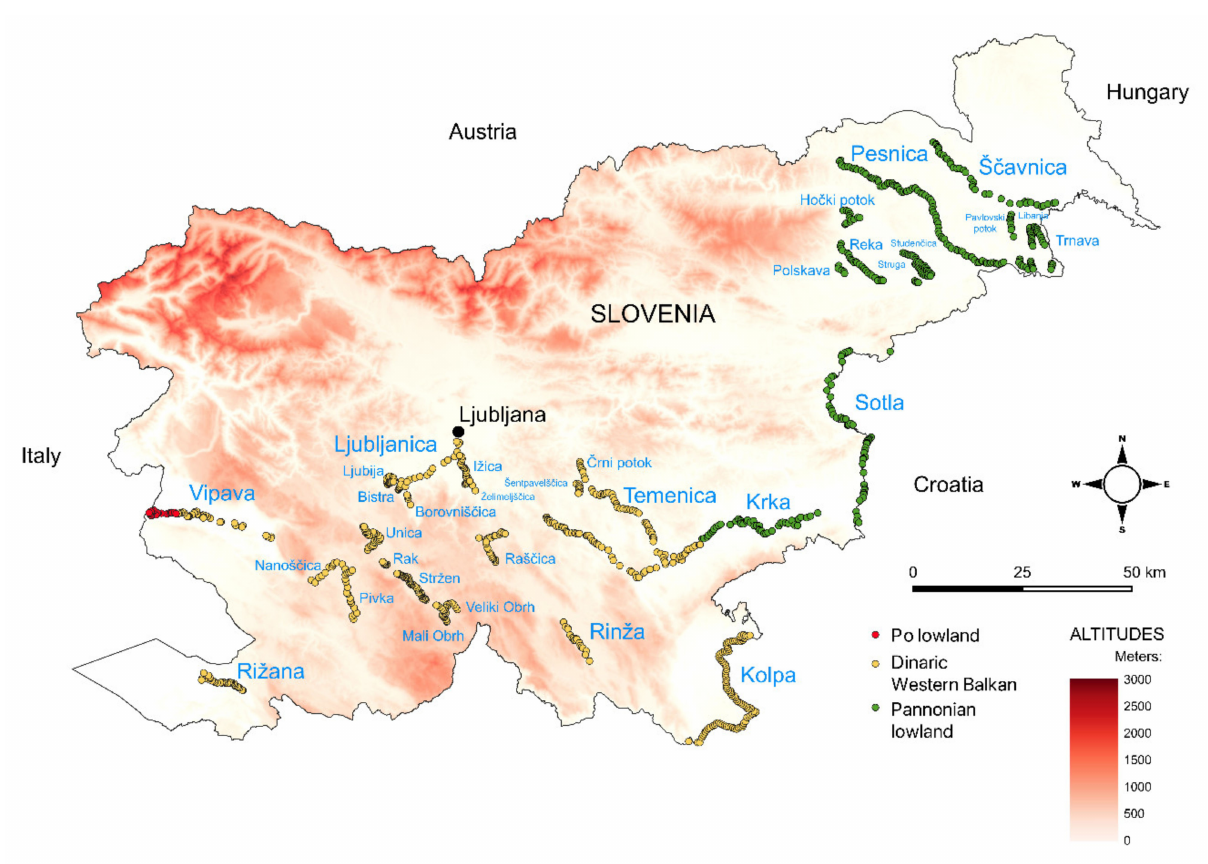
Figure 1. Map of Slovenia showing the distribution of surveyed sites. Circles of different colors indicate different hydro- ecoregions. The font size of the name roughly indicates the size of the specific